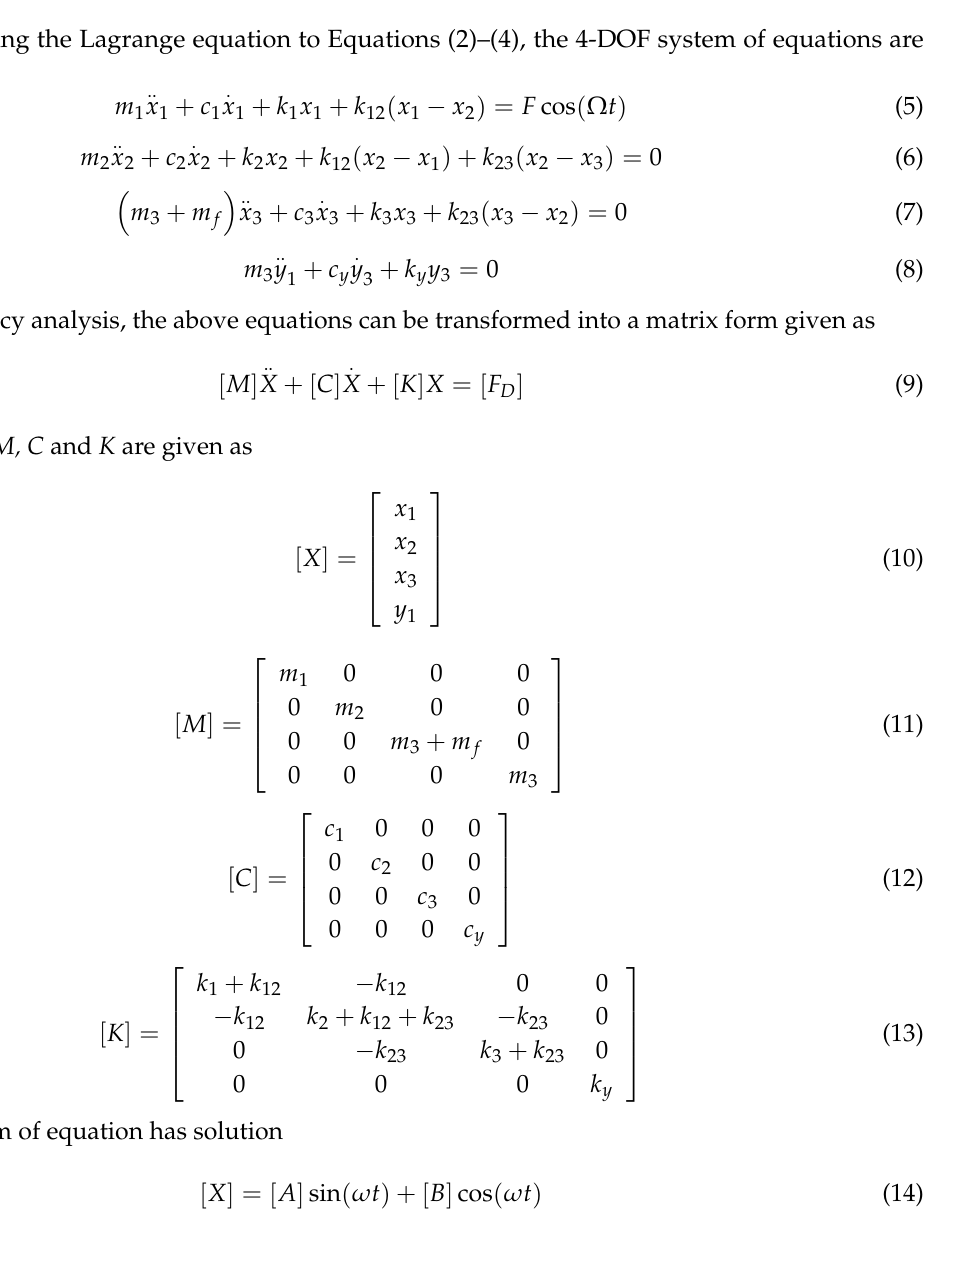
Figure 2. Lumped mass-spring-damper model of the proposed gyroscope, ( a ) 3-DOF drive mode, ( b ) 1-DOF sense mode.